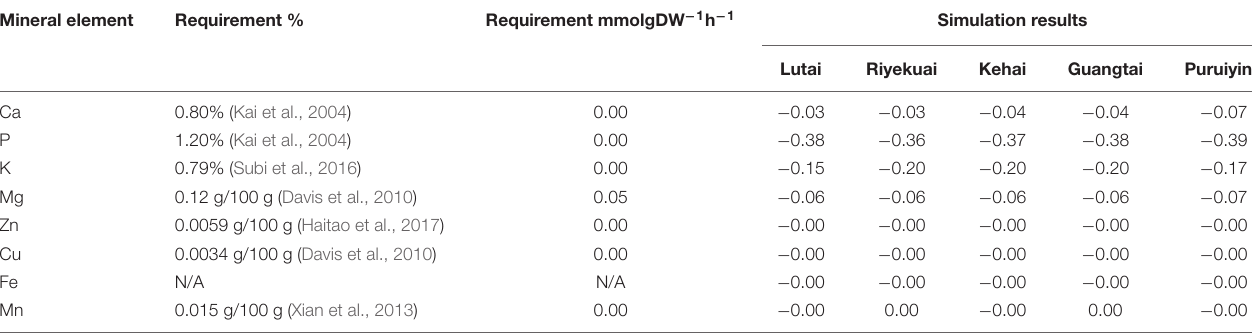
TABLE 7 | Requirements of mineral element by L. vannamei in literature and simulation results. Mineral element